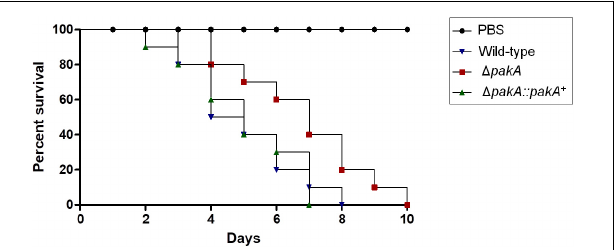
FIGURE 5 | Aspergillus fumigatus PakA contributes to virulence in G. mellonella . Comparative analysis of wild-type and mutant strains in G. mellonella animal model. Larvae in groups of 10 per strain were infected with a 5 µ l suspension of conidia at a dose of 1 × 106/larva. PBS, phosphate buffer